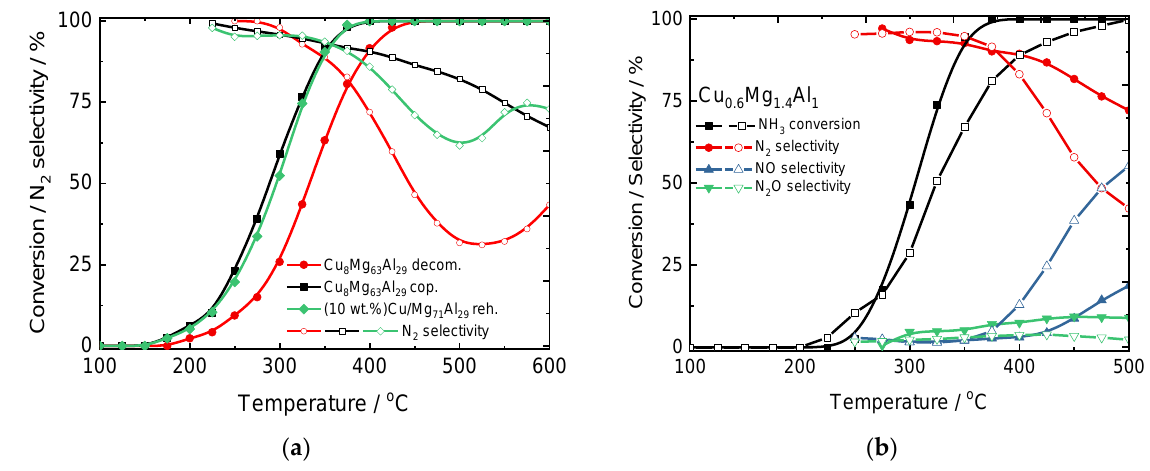
Figure 4. ( a ) Results of NH 3 -SCO over the CuMgAl mixed metal oxides. Reprinted from [34] with permission from Elsevier, and ( b ) results of NH 3 -SCO over the hydrotalcite-derived mixed metal oxides calcined at 600 and 900 °C. Reprinted from [28] with permission from Springer.